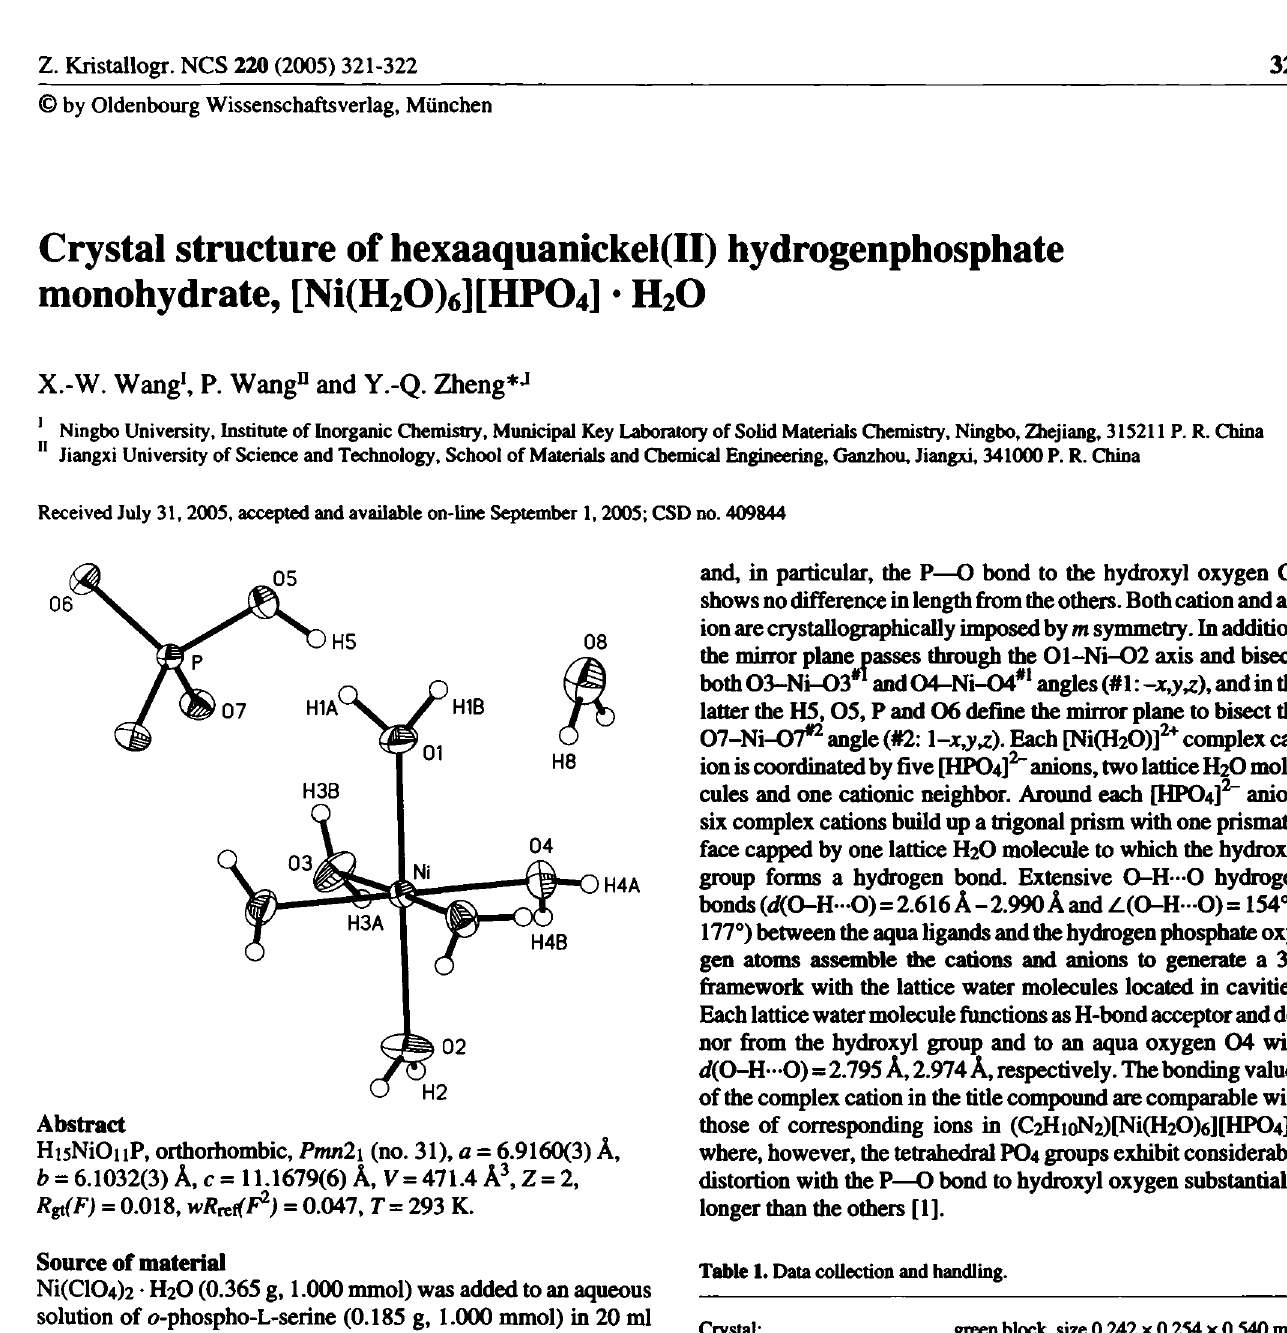
Table 1. Data collection and handling.